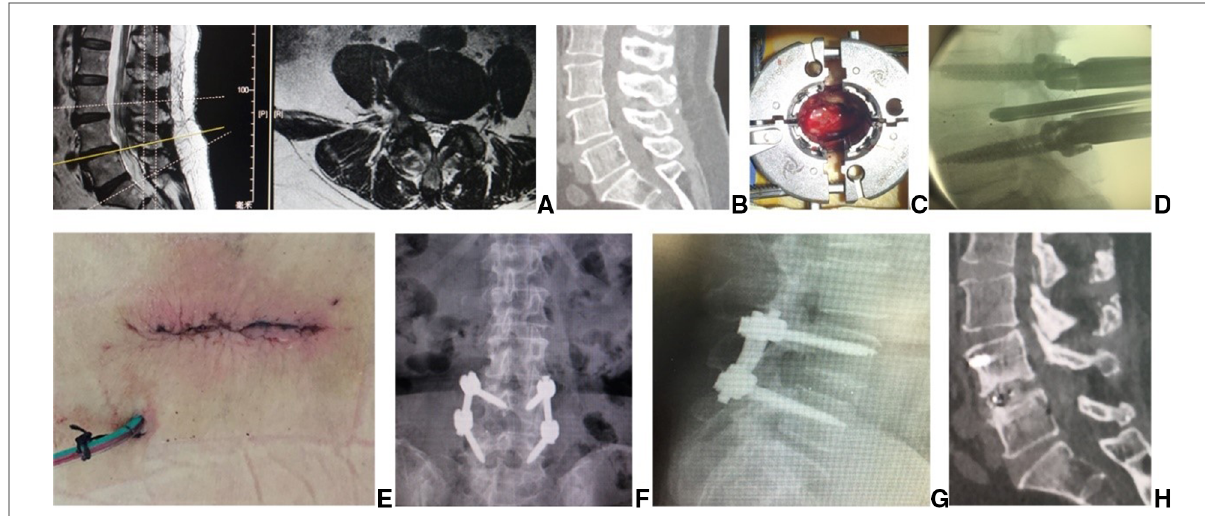
FIGURE 2 Female patient of 72 years with LDD at L4/5 had right leg pain. Preoperative ( A ) sagittal, axial MR and ( B ) CT images showed L4/5 disc herniation, lateral recess stenosis and neurologic compression. In MB-TLIF, ( C ) through an expandable tubular retractor, the dun and nerve root involved were exposed after a unilateral complete facetectomy and hemilaminectomy. ( D ) The fl uoroscopic image showed that a cage fi lled with autograft bone was inserted after the disc material and cartilaginous endplate were removed. Two rods were fi xed over pedicle screws and